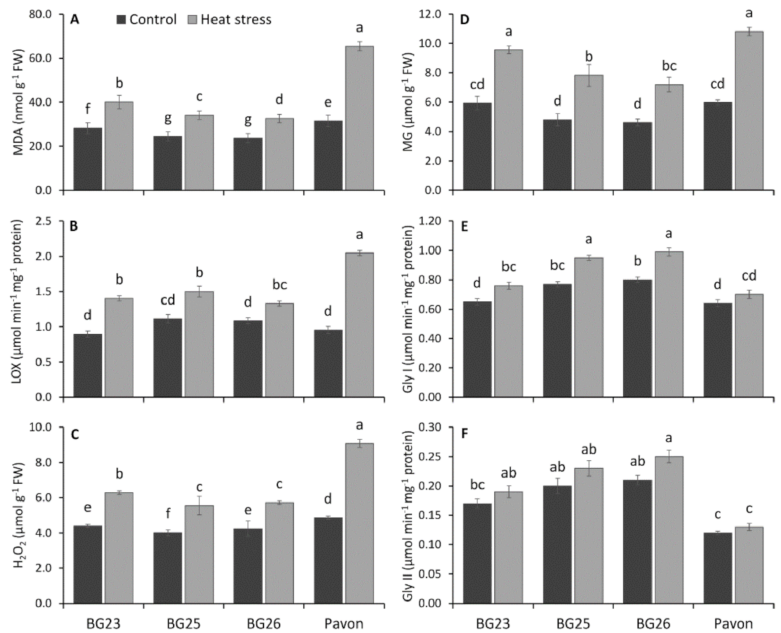
Figure 3. Changes in- ( A ) malondialdehyde (MDA), ( B ) lipoxygenase (LOX), ( C ) hydrogen peroxide (H 2 O 2 ), ( D ) methylglyoxal (MG) content and the specific activity of ( E ) glyoxalase I (Gly I) and ( F ) glyoxalase I (Gly II) enzymes of wheat varieties grown under control and heat-stressed conditions. Vertical bars represent +/ − SE values. Different letter(s) indicate significant difference at p <